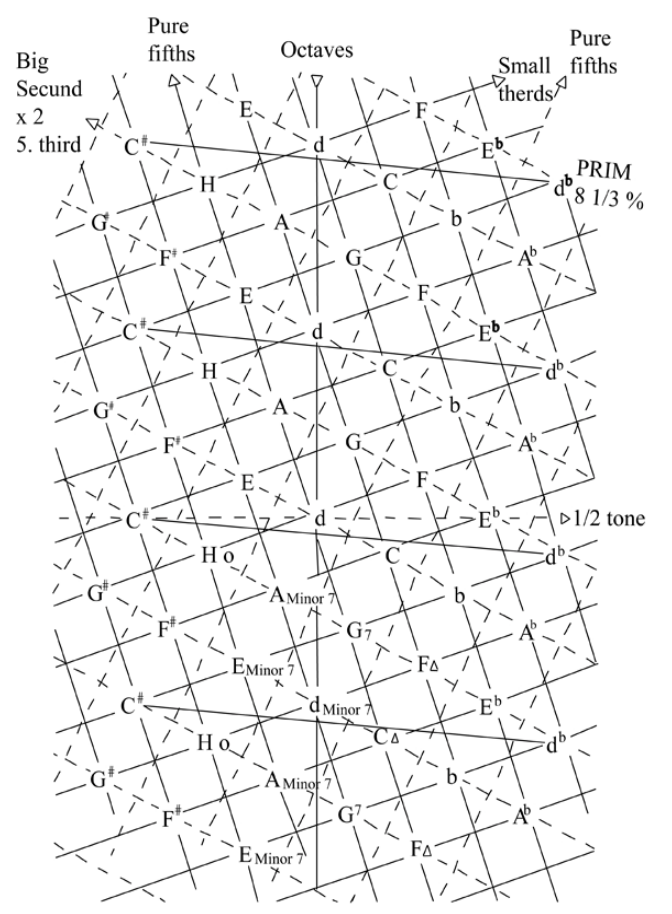
FIGURE 6 . An illustration of the pattern of a classical tone tissue with all its